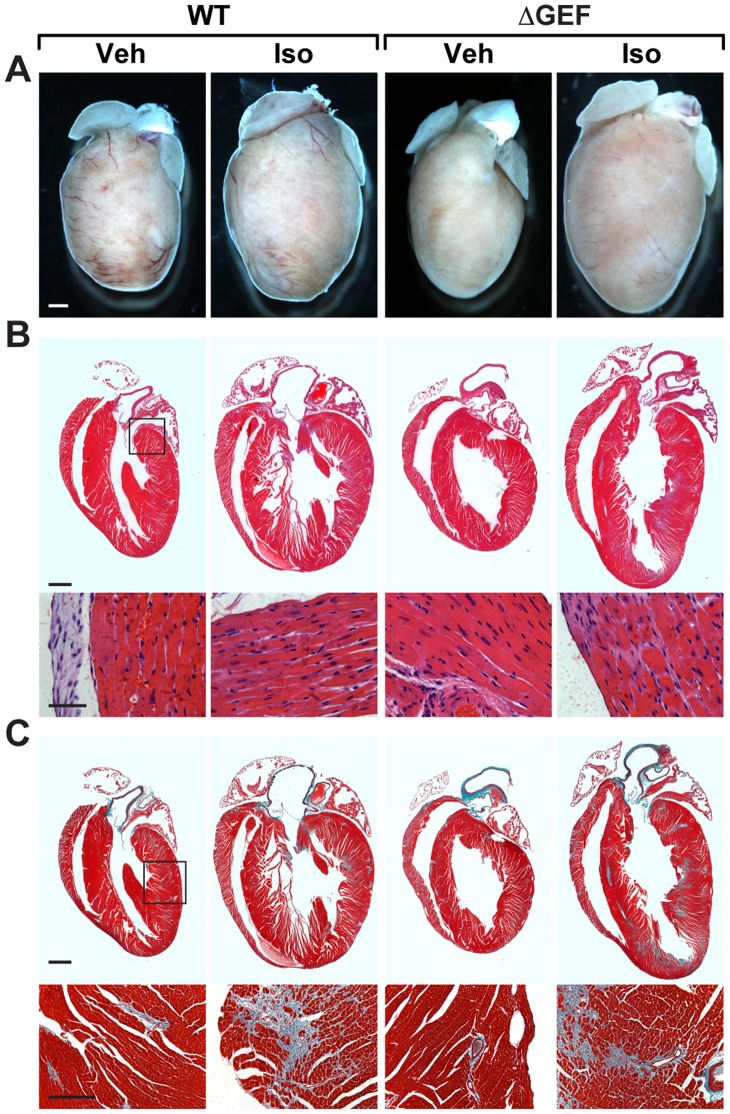
AKAP13-ΔGEF mutant mice induced cardiac hypertrophy in response to chronic isoproterenol treatment.(A) Hearts from wild-type (WT) and AKAP13ΔGEF/ΔGEF (ΔGEF) male mice showed hypertrophy with isoproterenol (Iso) treatment (60 mg/kg per day for 14 days). Three WT and three ΔGEF mice were treated with PBS vehicle (Veh), and four WT and six ΔGEF mice were treated with Iso; representative images are shown. White scale bar is 1 mm. Hearts were sectioned for histology and stained with (B) H&E or (C) Masson’s trichrome. (B) WT and ΔGEF left ventricular walls were thickened by Iso treatment (top). Higher magnification of the upper left ventricular wall (box) showed disruption of myocyte organization in Iso-treated hearts (bottom). (C) Fibrosis increased throughout the WT and ΔGEF hearts as assessed by Masson’s trichrome staining. Iso-treated ΔGEF hearts appeared to have more fibrosis than Iso-treated WT hearts. Higher magnification of the left ventricular wall (box) showed fibrosis within the myocardium (bottom). Black scale bars in B&C are 1 mm (top), 50 µm (B bottom), and 250 µm (C bottom).